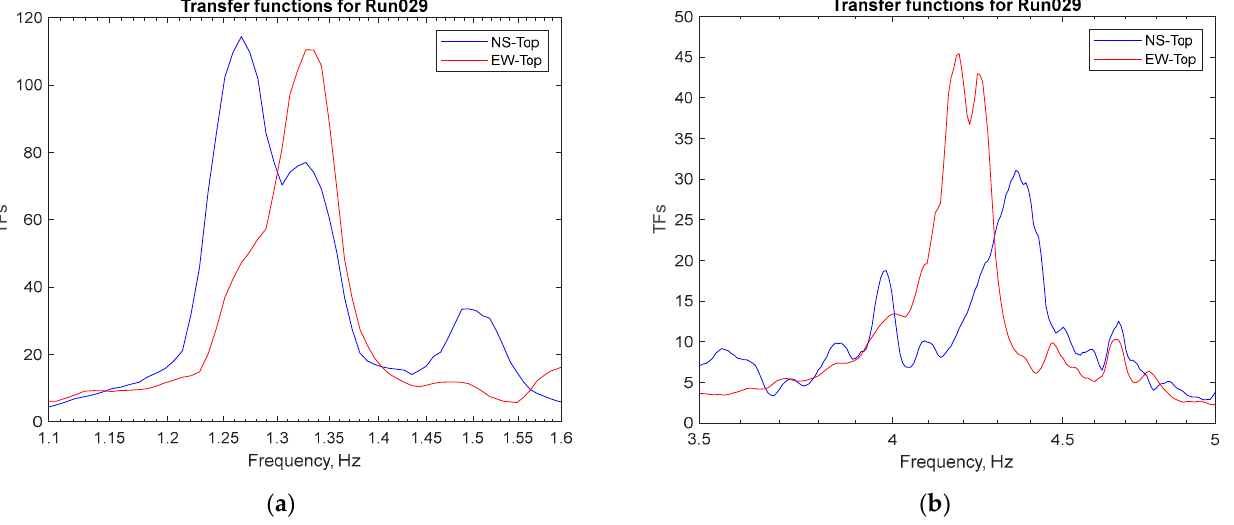
Figure 15. Typical results of resonant frequency estimates: ( a ) 1st mode of vibration; ( b ) 2nd mode of vibration.